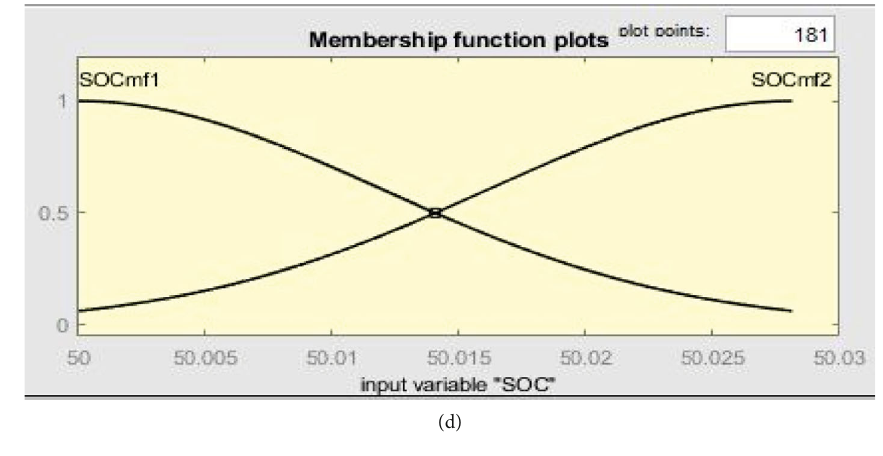
Figure 5: Membership